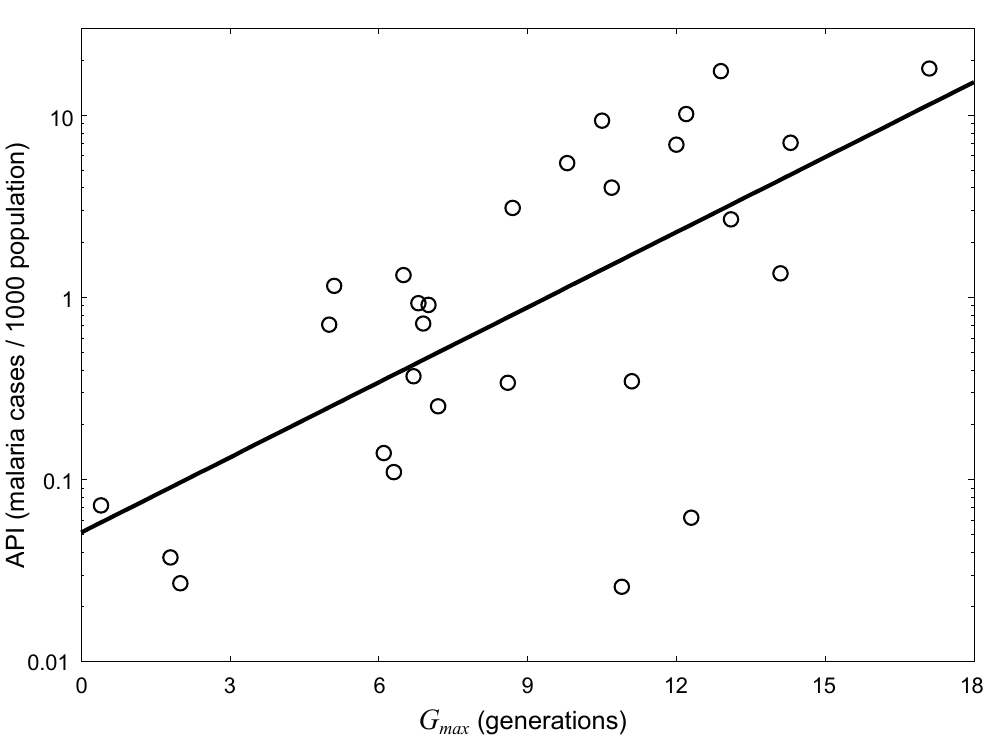
Figure 3. Relationship between averaged annual parasite index (API) from 2008 to 2010 and G in each state (open circle) of India. The solid line indicates a regression line max between API and G (API = exp (0.316 G − max max